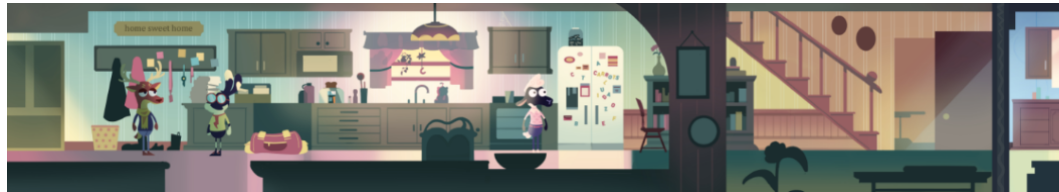
Figure 5. Bus scenario in the